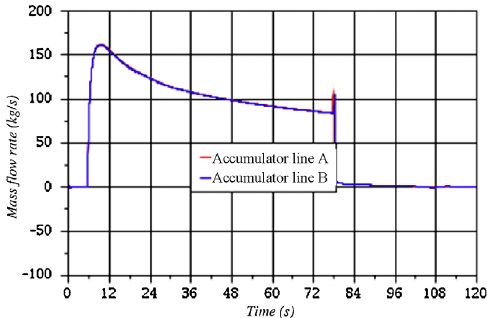
Fig. 16. Accumulators injection mass fl ow (kg/s).